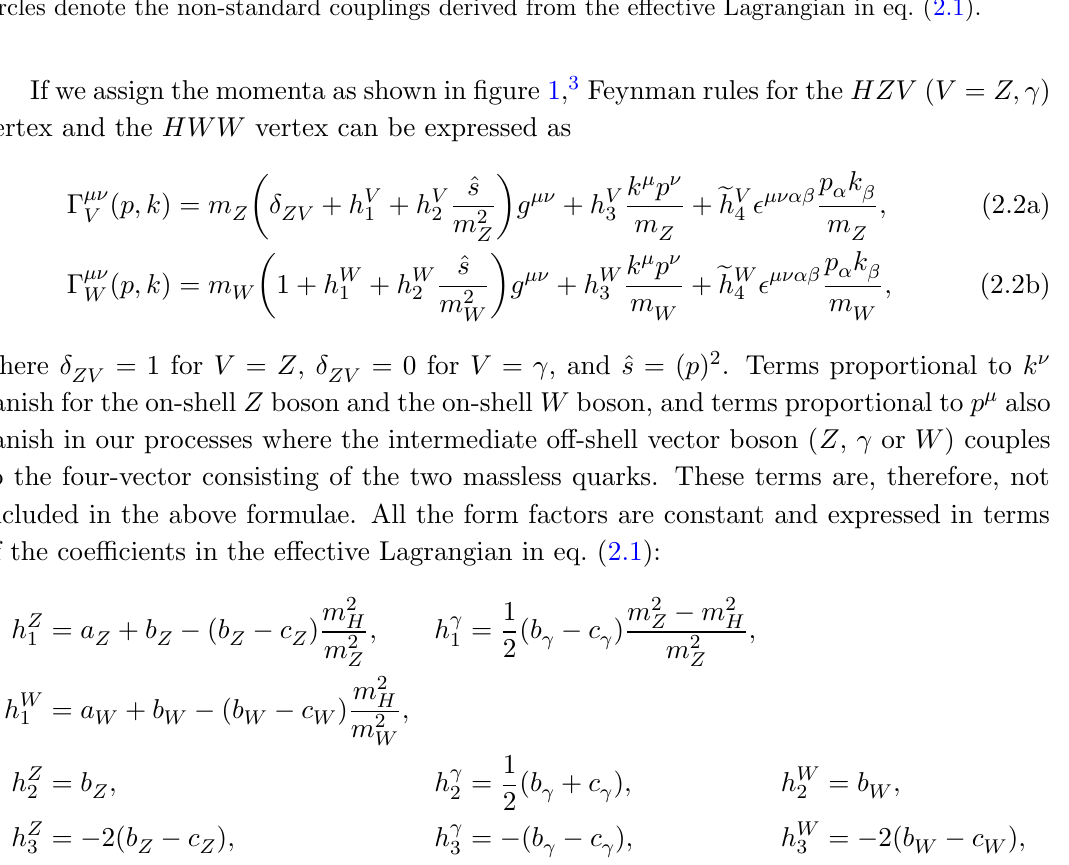
ZH , u (cid:22) d W + H and d (cid:22) u W (cid:0) H . The ! ! !